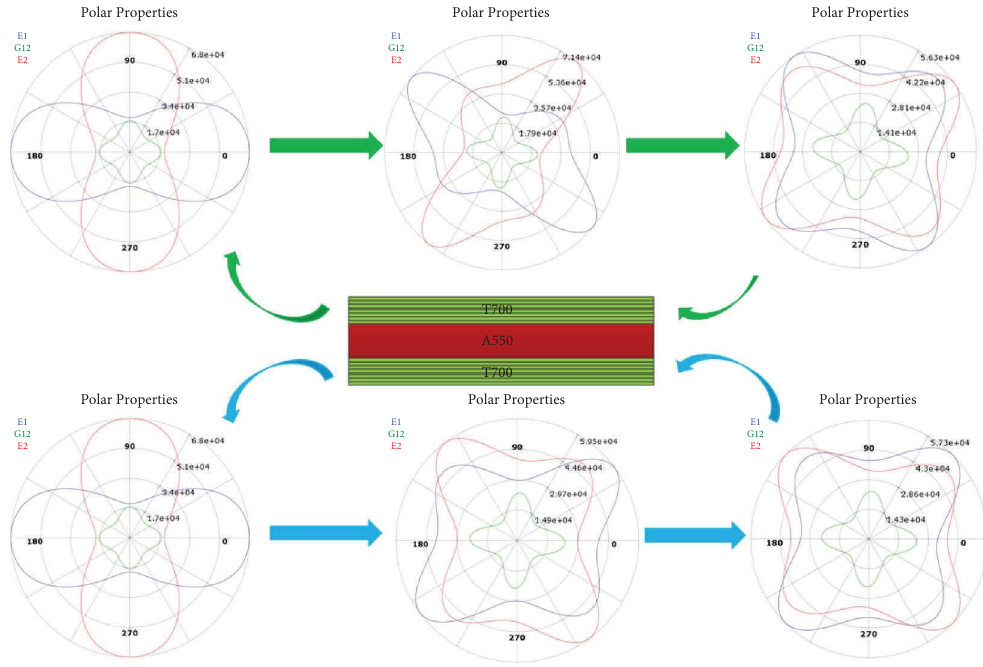
Figure 13: Change in laminate material